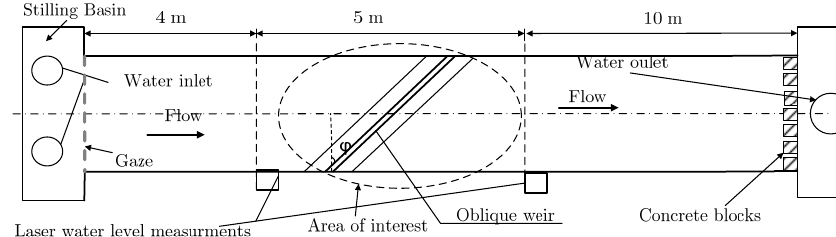
Fig. 9. Schematized plane view of the flume and measuring apparatus.